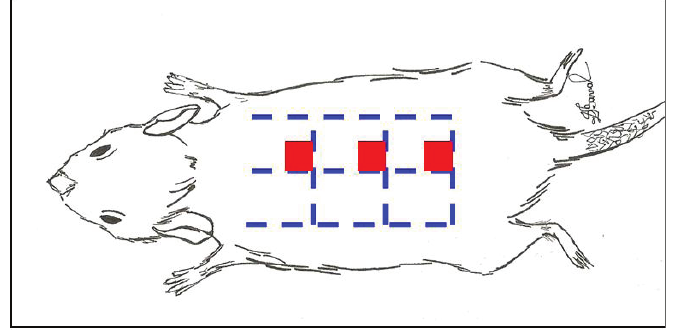
FIGURE 3 – Illustration representing the skin flap divided into three parts in the craniocaudal direction and the three fragments of 0.5x0.5 cm in the edge of each area, bordering the medial edge of the right half of the